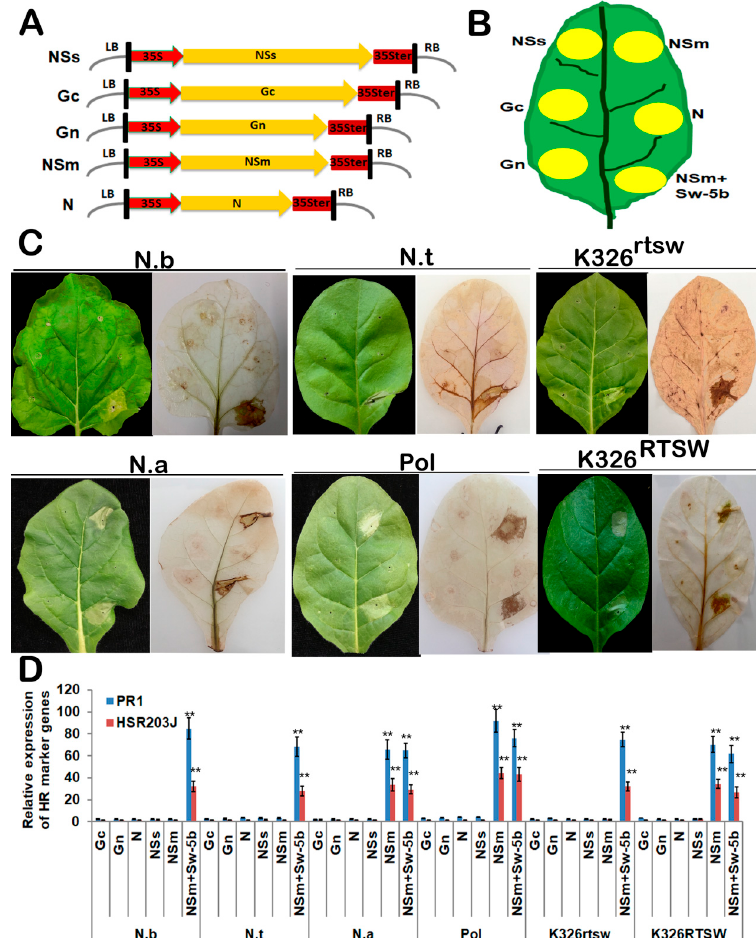
Figure 2. Transient expression of TSWV genes using agroinfiltration of 35S-based binary vectors in tobacco leaves. ( A ) Schematic representation of 35S-based expression cassettes. Five open reading frames (ORFs) were inserted between the 35S promoter (35S) and 35S terminator (35Ster). LB, left border; RB, right border. ( B ) Schematic representation of a tobacco leaf showing the infiltration areas of various 35S-based expression cassettes. ( C ) Photographs of tobacco leaves exhibiting HR symptoms (left) or production of H 2 O 2 (right) 2 days after agroinfiltration with transient expression constructs. Leaves on the right were stained with 3,3-diaminobenzidine (DAB). Co-infiltration of NSm with Sw-5b (NSm + Sw-5b) was used as a positive control in each leaf. N.b, Nicotiana benthamiana ; N.t, N. tabacum cv. K326; N.a, N. alata ; Pol, Polalta; K326 rtsw , plants derived from the BC5F1 population of Polalta × K326 lacking the RTSW gene and susceptible to TSWV; K326 RTSW , plants derived from the sme BC5F1 population but carrying the RTSW gene and resistant to TSWV. ( D ) qRT-PCR analysis of HSR203J and PR1 expression in leaves shown in panel (C). The GAPDH gene was used as a reference. Data represent mean ± SEM of three independent experiments ( n = 6). Asterisks indicate statistically significant differences (**, p < 0.01; Student’s t